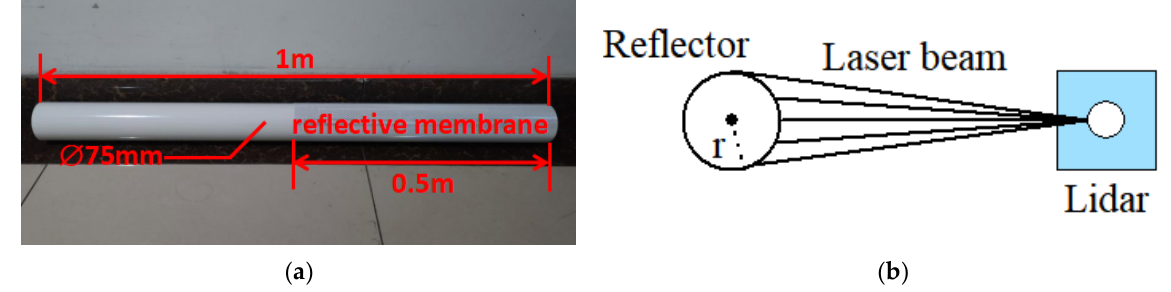
Figure 5. Details about reflectors. ( a ) An example of a reflector in this paper. The reflector is a cylinder with a length of 1 m and a diameter of 75 mm covered by a reflective membrane ( b ) Standard of selecting dimension of reflectors. This standard ensures that the LiDAR can scan enough point clouds to fit the reflector coordinates.